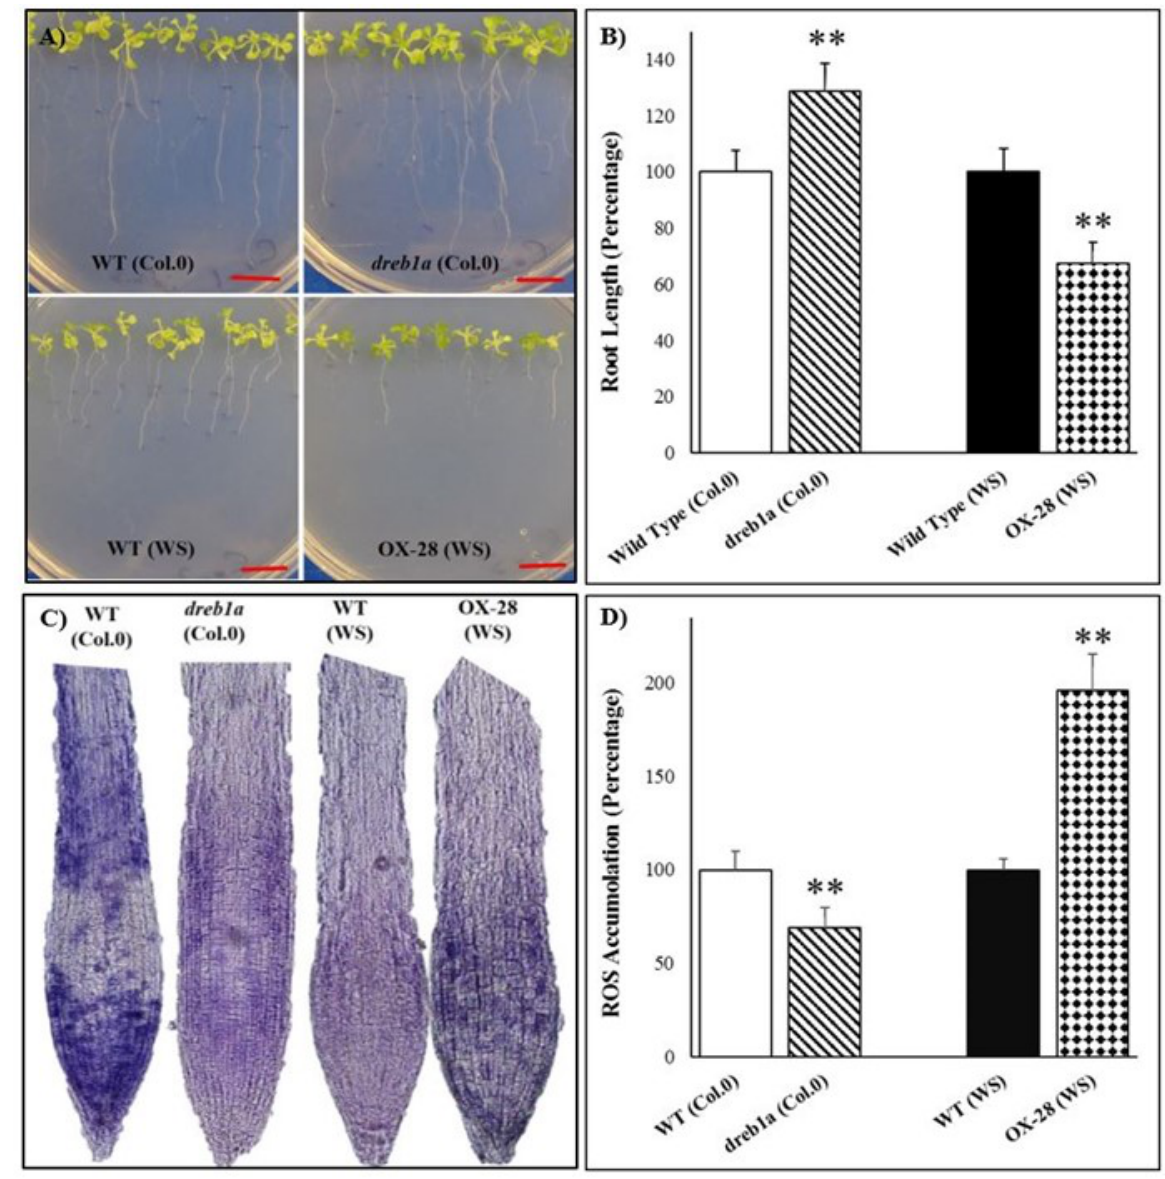
Fig. 3. Root growth and H 2 O 2 accumulation analysis in dreb1a and OX-28 plants: A) Representative dreb1a and OX-28 plants alongside their control wild types 20 days after planting on the MS medium, Bar=1 cm; B) Comparison of root length 20 days after planting on the MS medium; C) NBT staining (indicating H 2 O 2 production sites) of root tips in dreb1a and OX-28 plants alongside their control wild types 20 days after planting on the MS medium; D) Comparison of H 2 O 2 accumulation at the root tips 20 days after planting on the MS medium; Bars indicate standard deviations of replicates determined by one-way ANOVA (P < 0.05), confirmed by t -test at P <0.05 (*), P <0.01 (**) or P <0.001